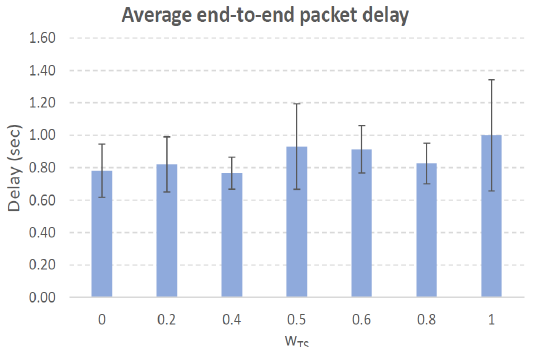
Figure 9. Average end-to-end packet delay. Scenario with low social media interaction (TS normal distribution with µ = 2 and σ = 1). Nodes’ density = 100 nodes/km 2